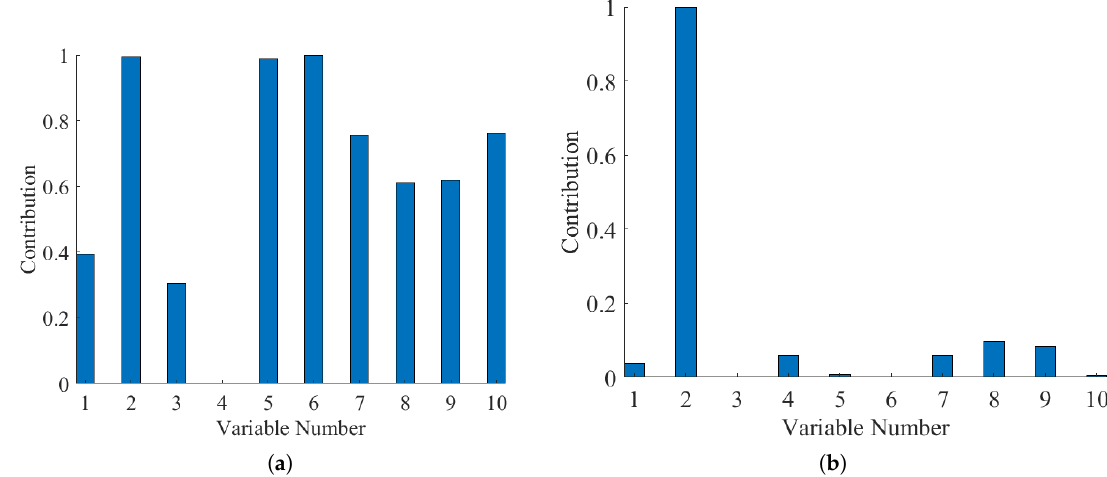
Figure 11. The fault contribution rate for each variable in Case 2. ( a ) The Contribution of different variables in observations 2250 to 2450, ( b ) The Contribution of different variables in observations 2450 to